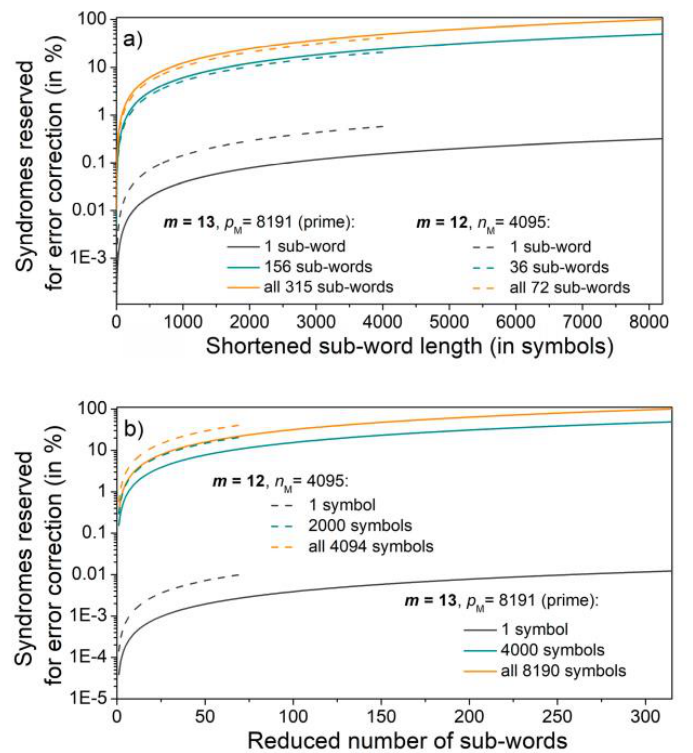
Figure 3. The effect of code-word shortening on error detection: shortening the sub-words ( a ) and reducing the number of sub-words ( b ) decreasing the number of syndromes that indicate correctable error, thus increasing the possibility for error detection. The number of syndromes that correspond to correctable errors can reach 100% only if 2 m − 1 is Mersenne prime, here shown for m = 13.